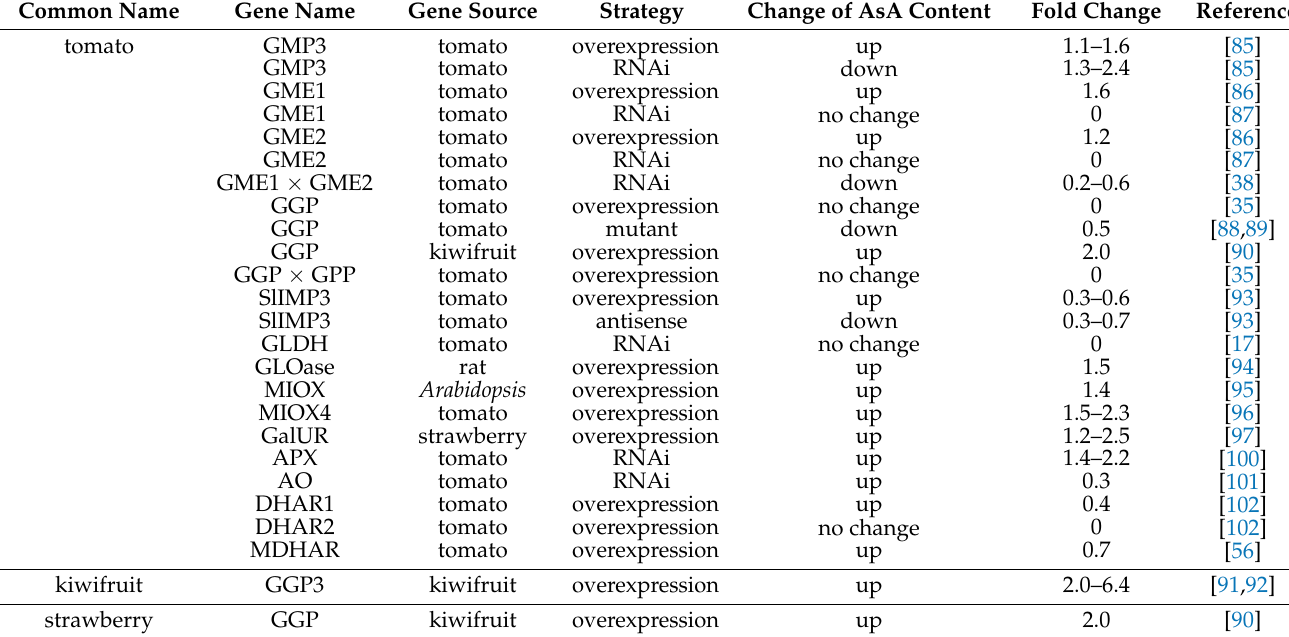
Table 2. Relationship between expression patterns of AsA metabolism-related genes and AsA accumulation in